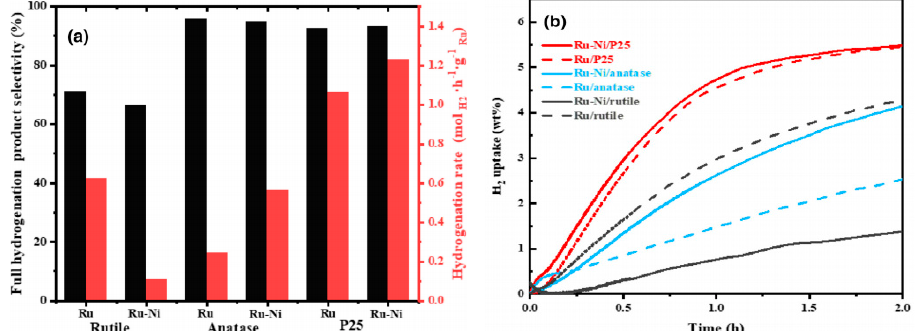
Figure 2. Catalytic performances of as-prepared catalysts. ( a ) The left axis shows selectivity toward the full hydrogenation product 12H-NEC (after reacting 24 h); the right axis shows the hydrogenation rate. Reaction condition: 150 °C, 70 bar H 2 , 2.5 g NEC, 0.125 g catalyst, 24 h, stirring at 200 rpm. ( b ) The first